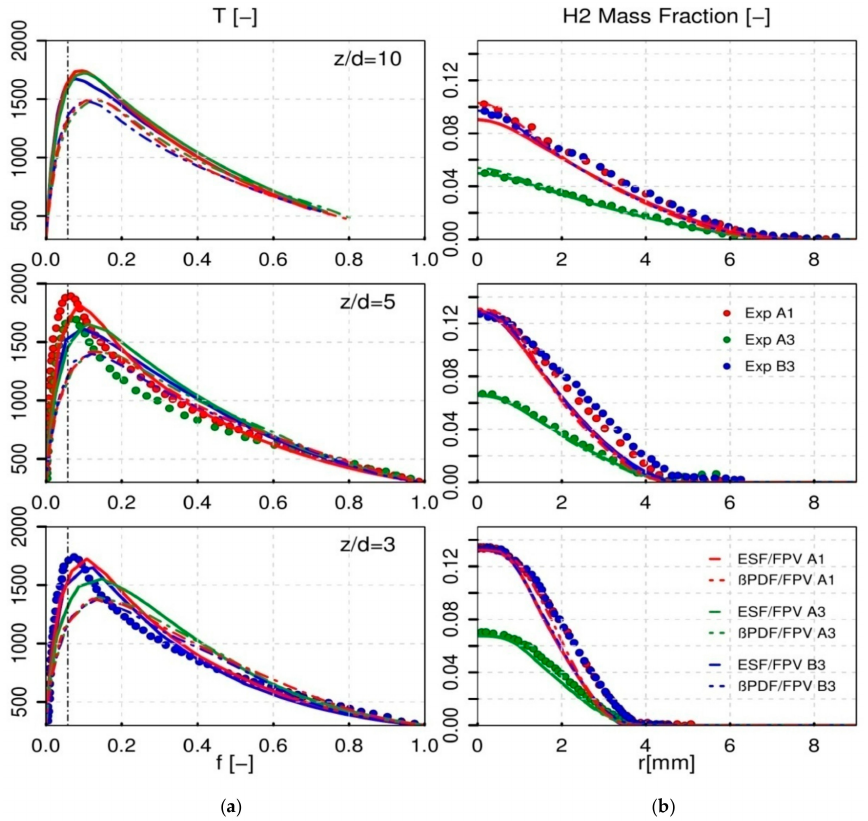
Figure 10. Mean temperature profile in mixture fraction space ( a ) and H 2 mass fraction ( b ) results from ESF/FPV simulation with 48 SFi at different axial positions for flame cases A1, A3 and B3 in comparison with β -PDF results and Raman/Rayleigh data from